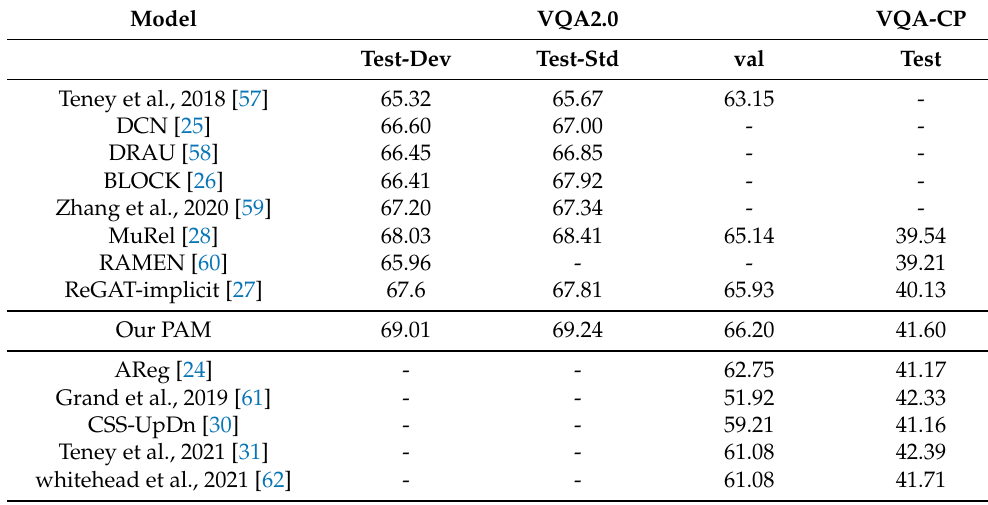
Table 2. Model accuracy on the VQA 2.0 and VQA-CP